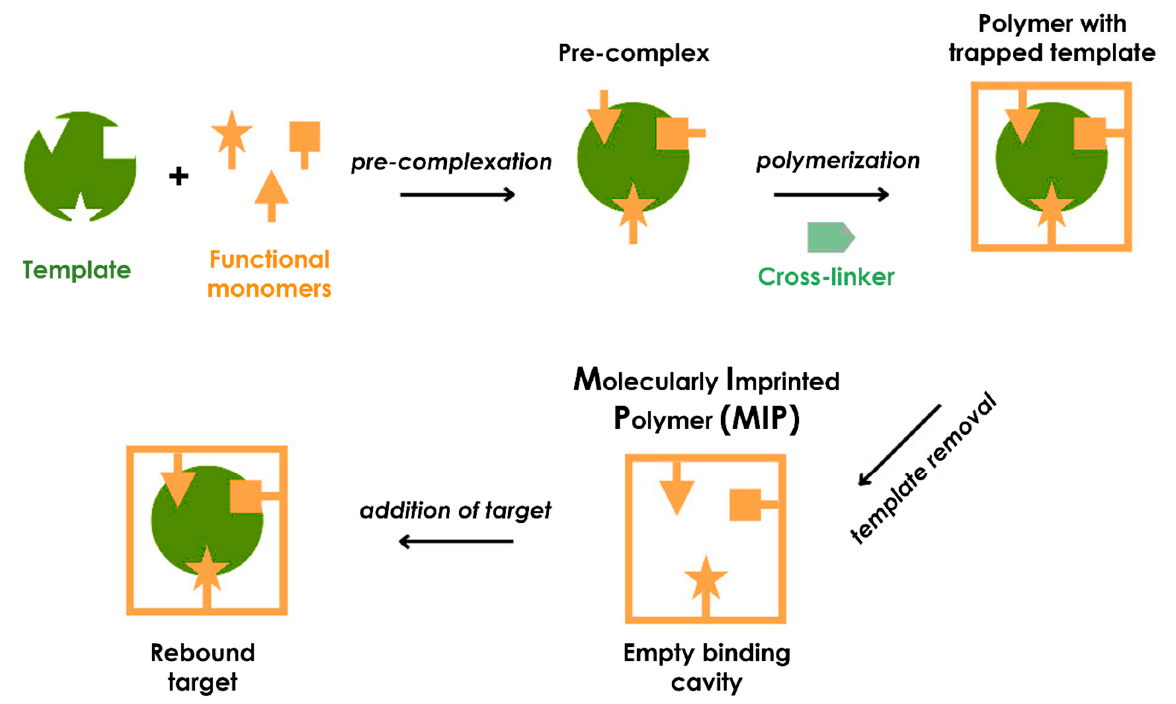
Figure 1. Molecularly imprinted polymers (MIPs) synthesis. (Reproduced with permission from [11], open access Creative Common CC licensed 4.0, MDPI).